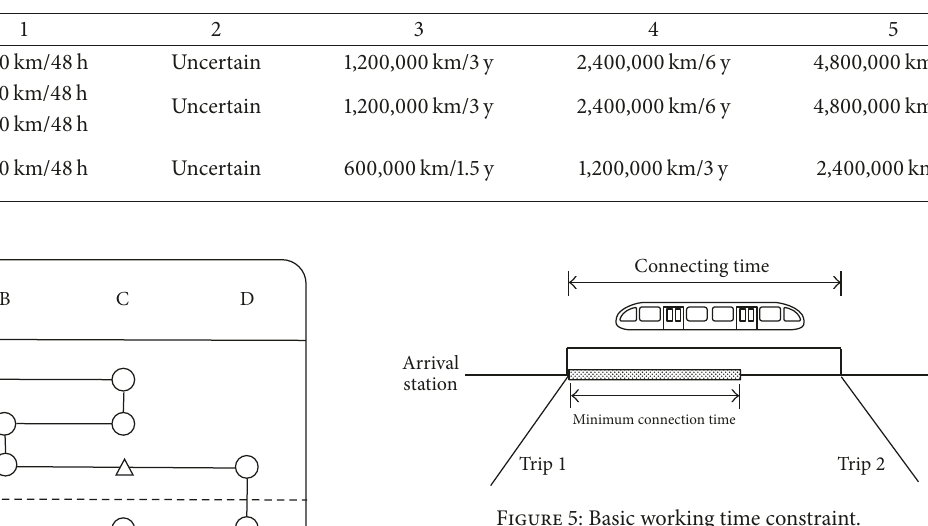
Table 2: Maintenance standard of train-sets in China.